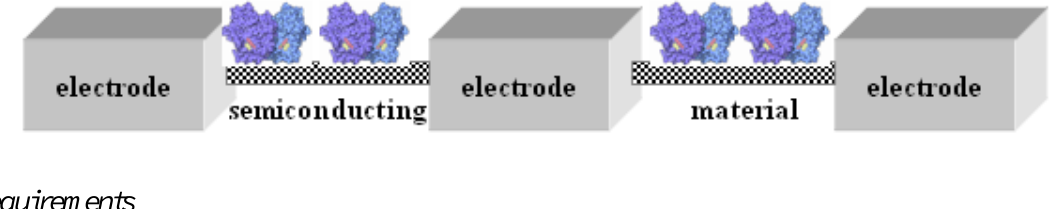
Figure 10. Modified GOx